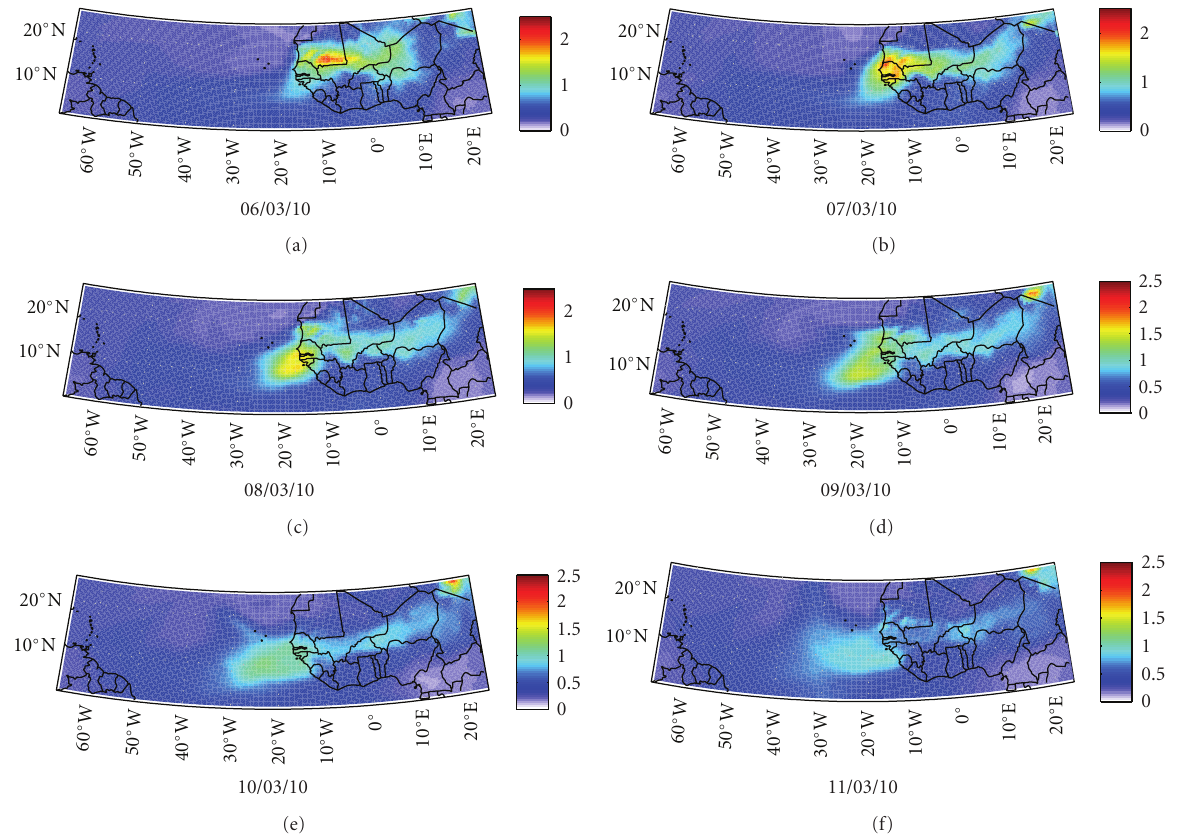
Figure 4: Evolution of dust particles (episode of March 5–8th simulated with the RegCM 4.0) from the African continent towards the Atlantic Ocean between March 6–11th